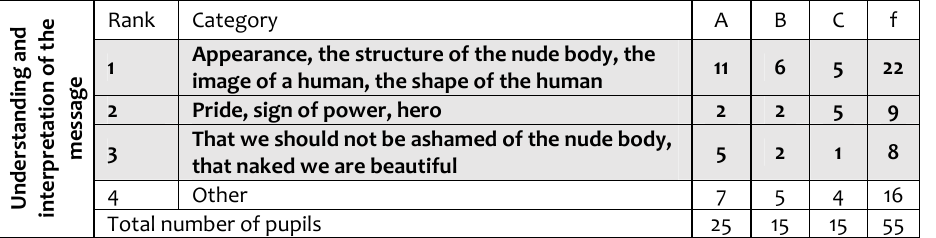
Table 5: Ranking order of the categories of answers regarding the understanding and interpretation of the message of the first example (Michelangelo: David,